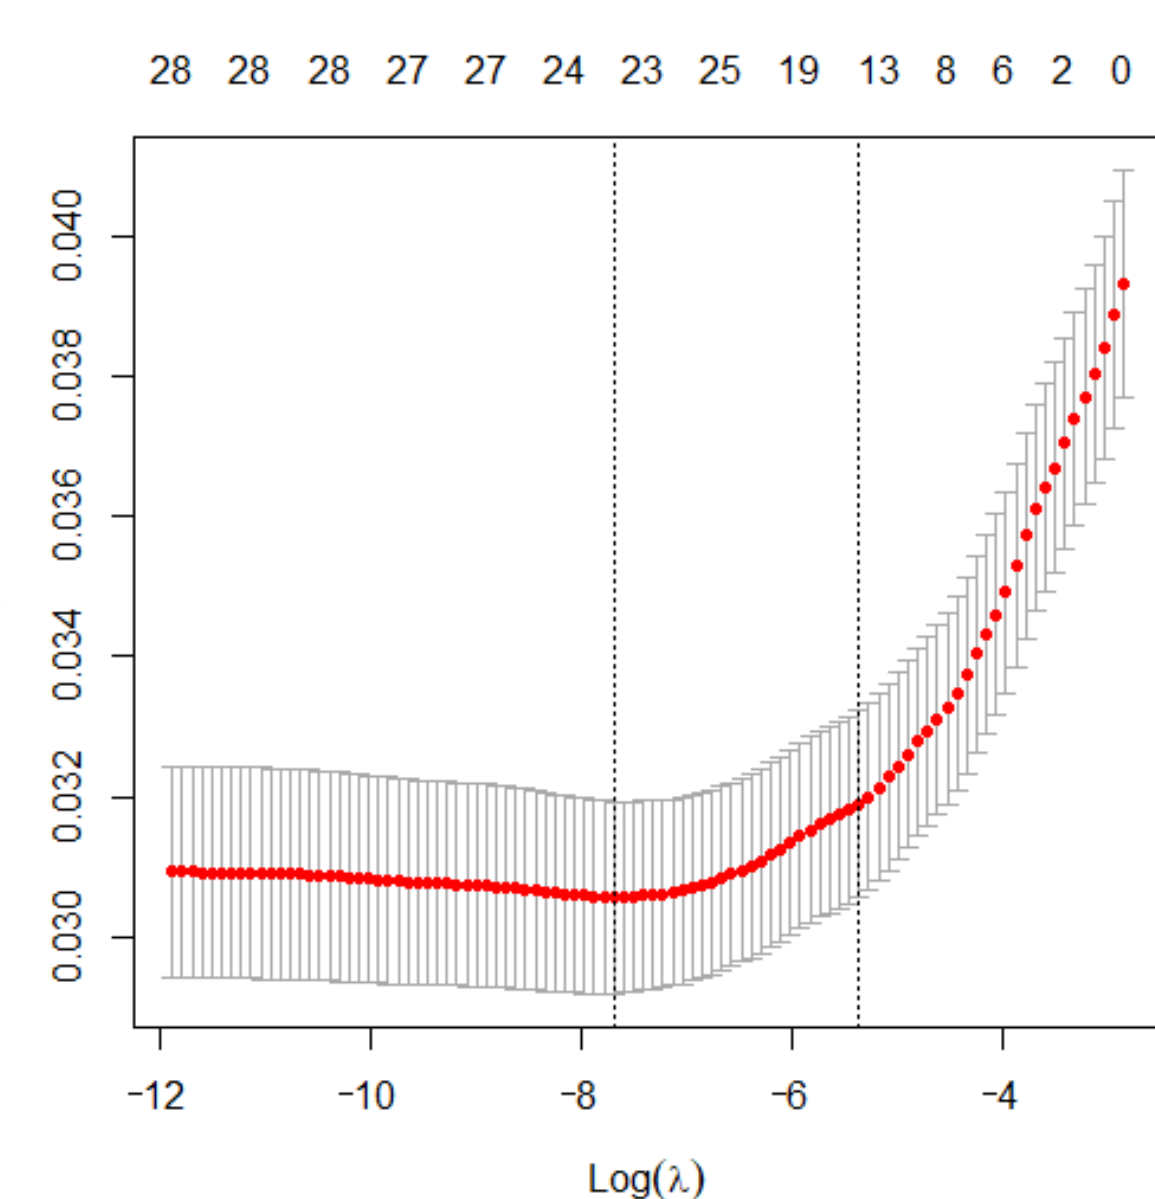
Figure 5. Glmnet package filter variable process Lambda values.